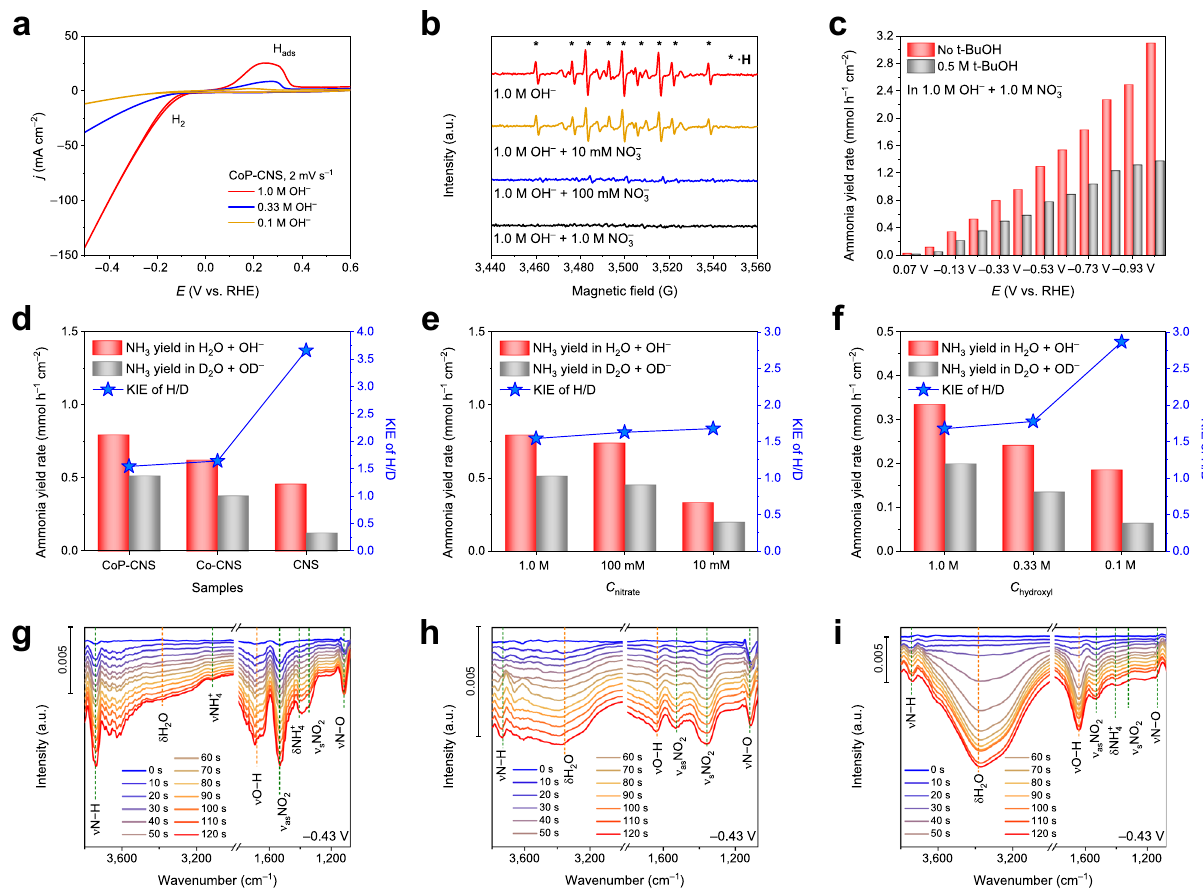
Fig. 4 | Furnishing active hydrogen promotes the NITRR to produce NH3. a CV curves of CoP-CNS in different c OH – without NO 3 – . b ESR spectra of the CoP-CNS catalyzedNITRRsolutionswithdifferent c NO 3 – usingDMPOastheradicaltrapping reagent. c NH 3 yieldratesofCoP-CNSunderpotentialrangefrom0.07to − 1.03Vvs. RHEwith and without 0.5M t-BuOHquencher. d – f KIE ofH/D over d CoP-CNS, Co-